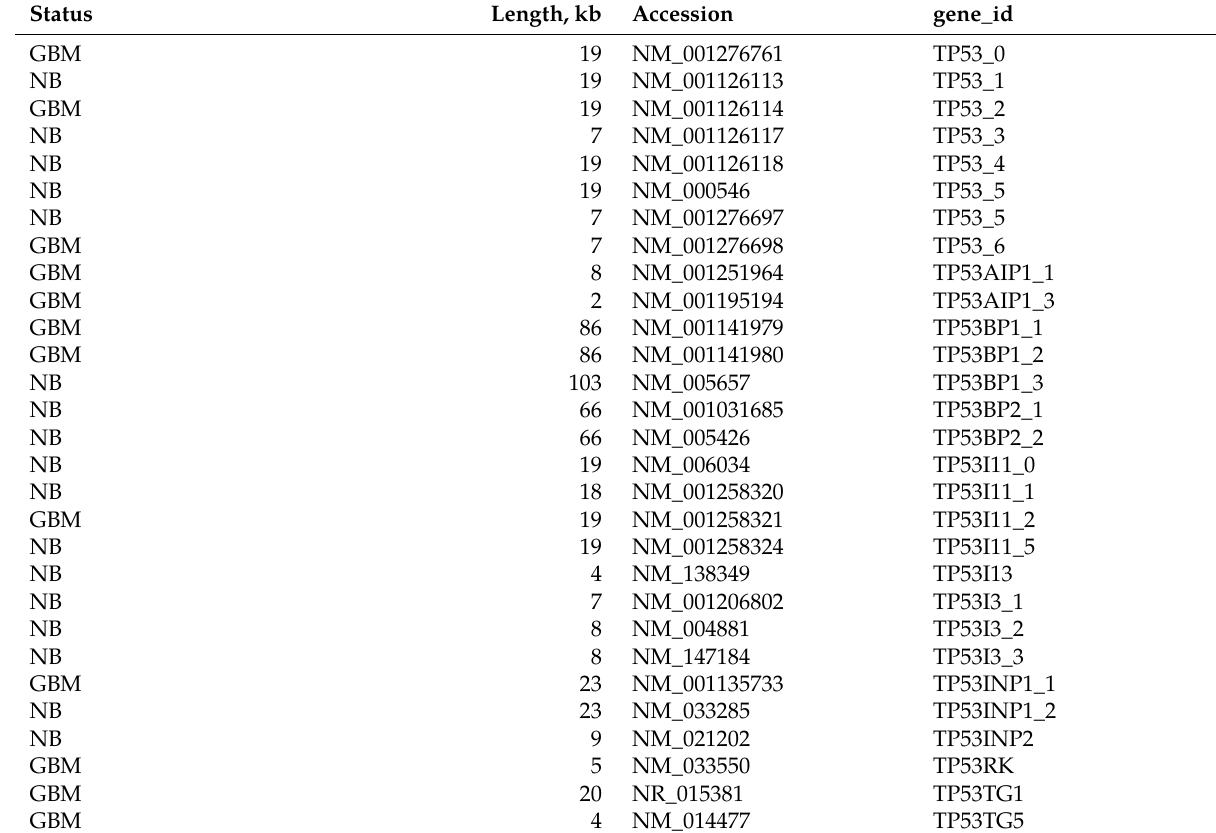
Table 3: RefSeq accession numbers and gene ID for the TP53 related genes used. Status Length,